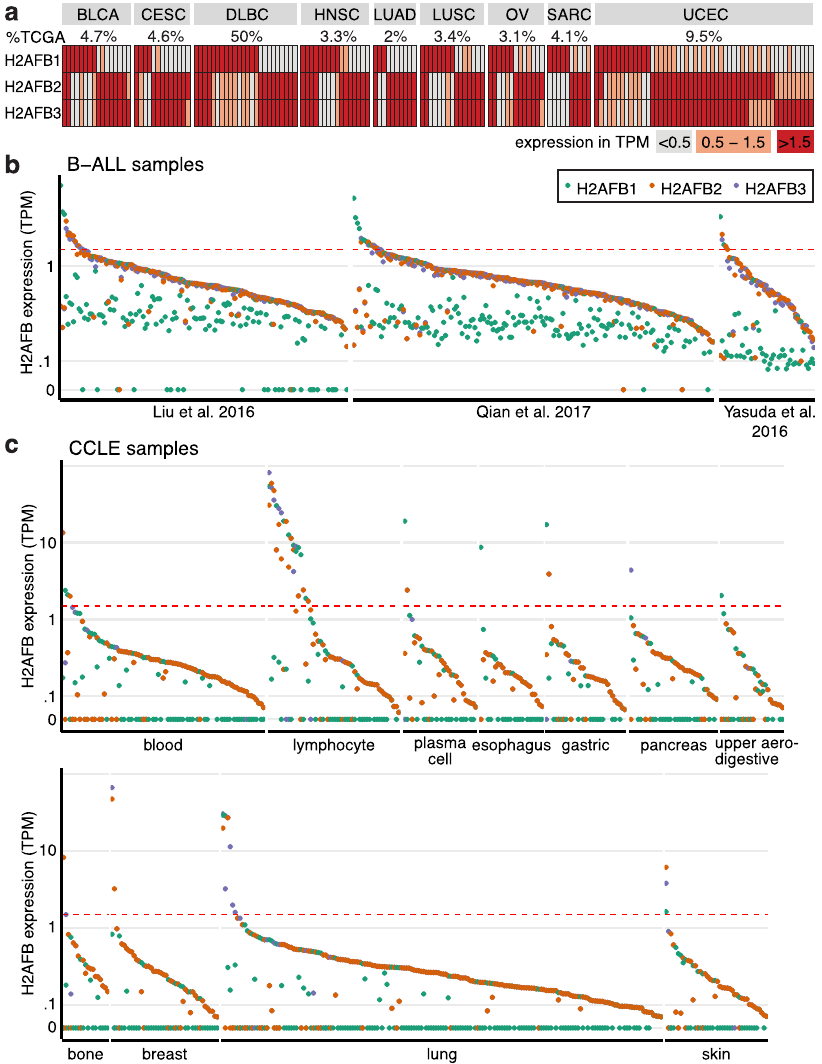
Fig. 2 H2A.B is expressed in a broad array of cancers. a Heat map illustrating the co-expression of H2A.B paralogues in individual tumors that express any one H2A.B paralogue (at >1.5 TPM as measured by RNA-seq), for cancer types with at least 10 tumors expressing any H2A.B paralogue. Percentages of tumors for each cancer type that express any H2A.B paralogue are shown. b Expression levels (TPM) of H2A.B-encoding transcripts in three independent B-acute lymphoblastic leukemia data sets, horizontal line demarcates 1.5 TPM as measured by RNA-seq. Only samples with non-zero expression of any H2A.B paralog are shown: 18, 5, and 1 samples are omitted from Liu et al. 2016, Qian et al. 2017, and Yasuda et al. 2016, respectively. c As in b , but for cancer cell lines from CCLE, grouped by their lineage. Only lineages with any sample >1.5 TPM, and samples with non-zero expression of any H2A.B paralog are